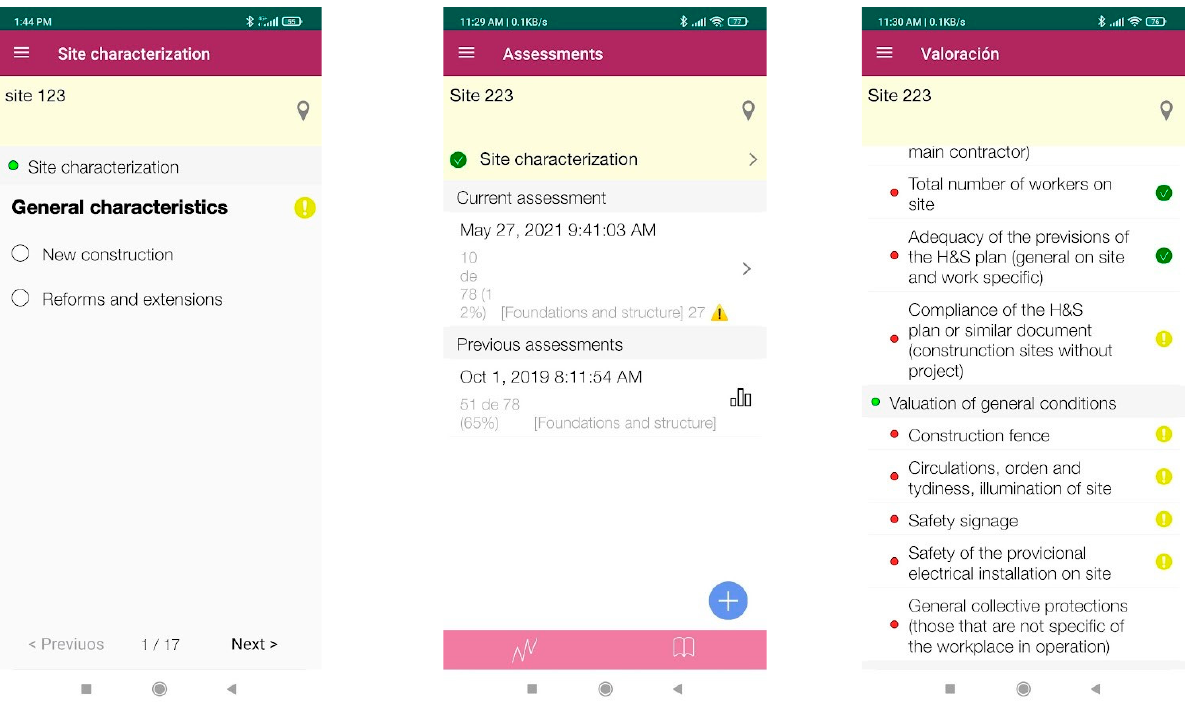
Figure A2. Questions for site characterization. Finalization of characterization and continuing assessment. Source: App screenshots.